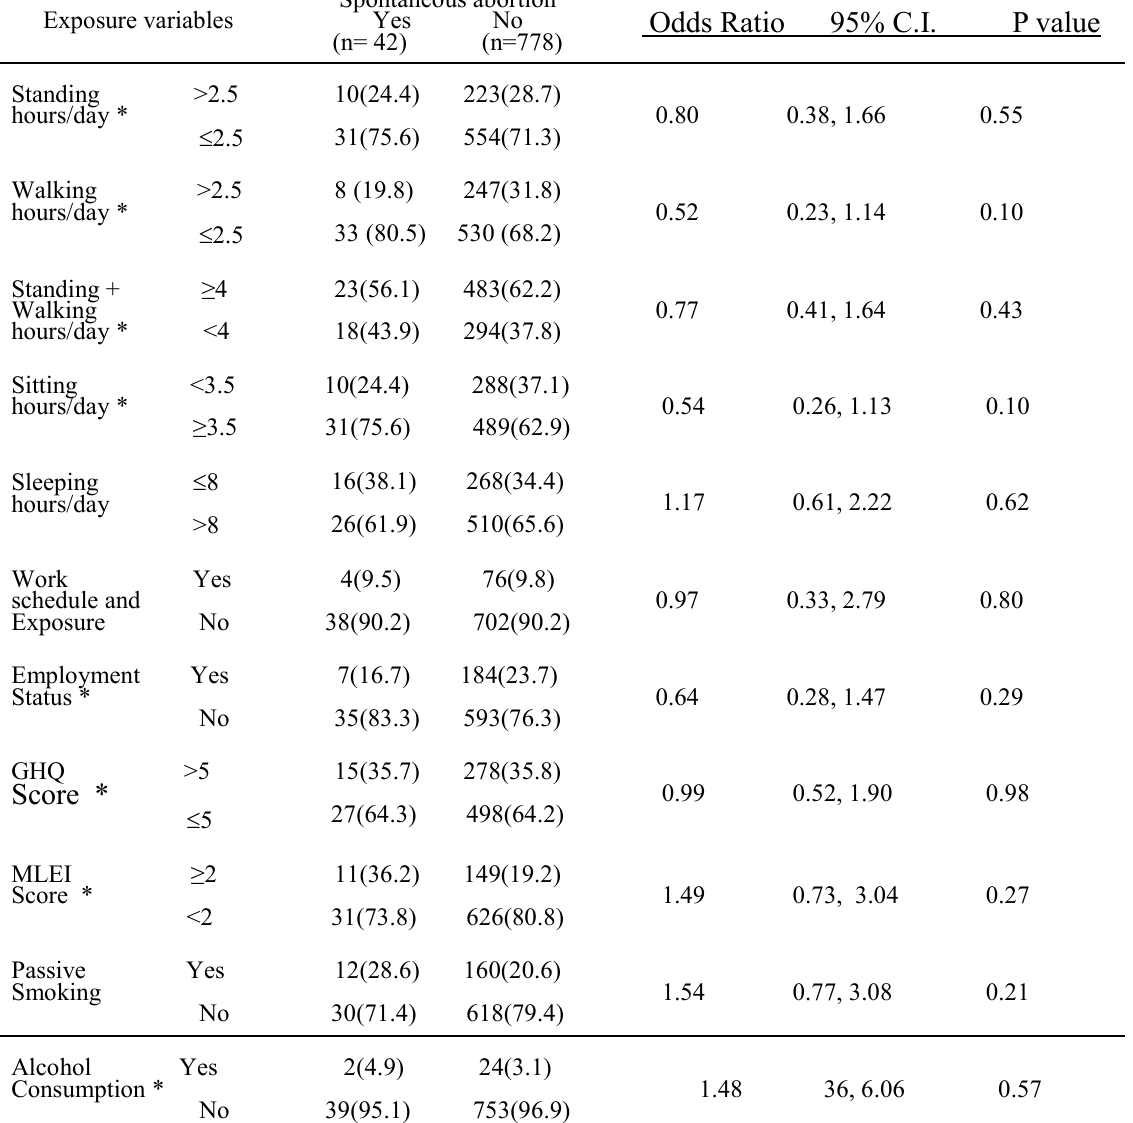
Table 2 - Unadjusted odds ratios for spontaneous abortion by other exposure variables Exposure variables